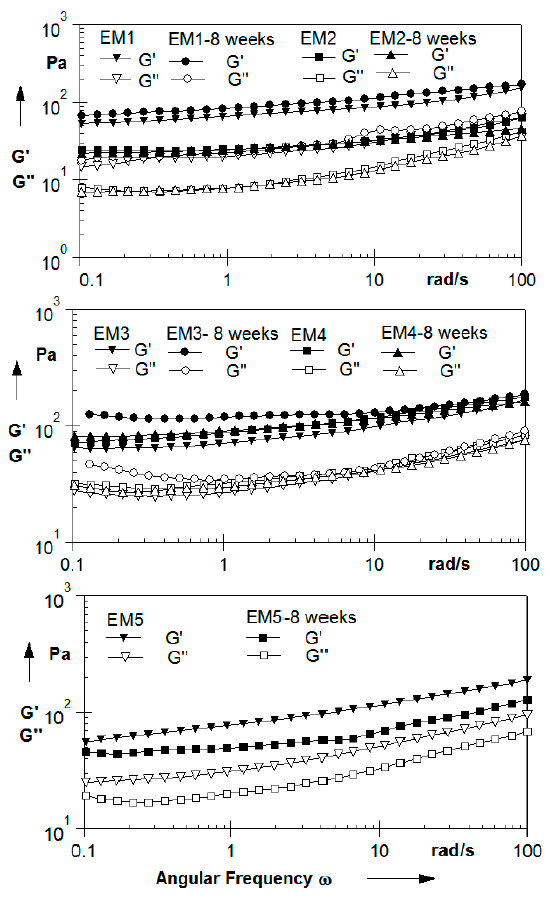
Figure 3. Frequency sweeps recorded for the as-prepared and stored emulsions with different amounts of polar fraction in interesterified fat (the content of polar fraction has been given in Table 1). Error bars for the measured values are within the size of point